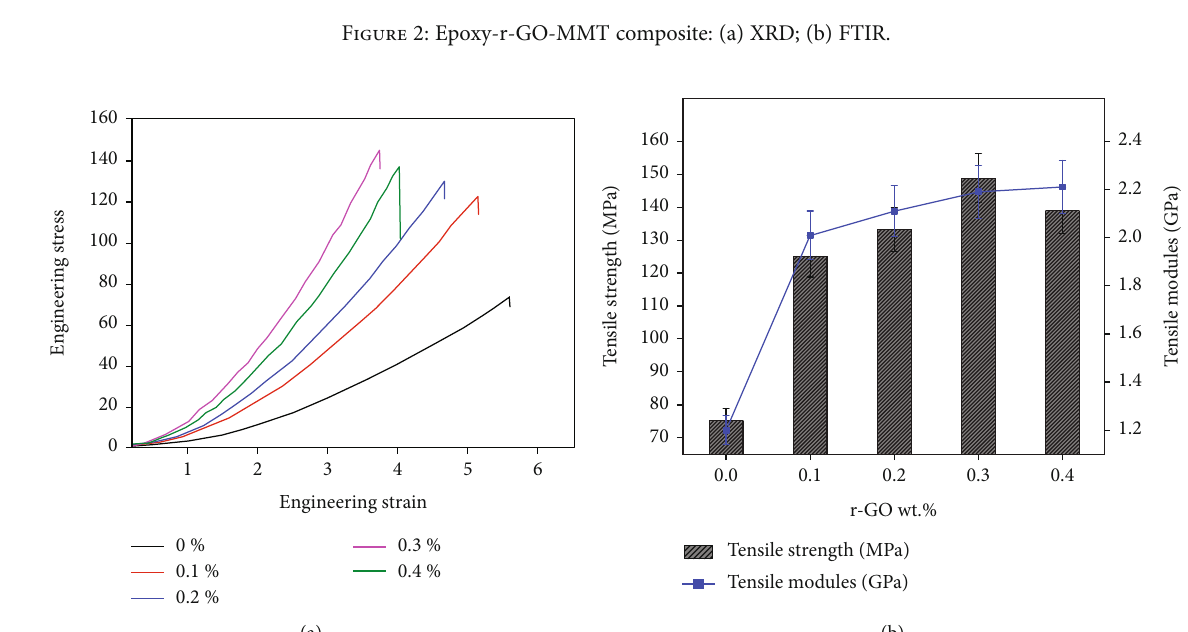
Figure 3: (a, b) Variation of tensile strength with respect to r-GO